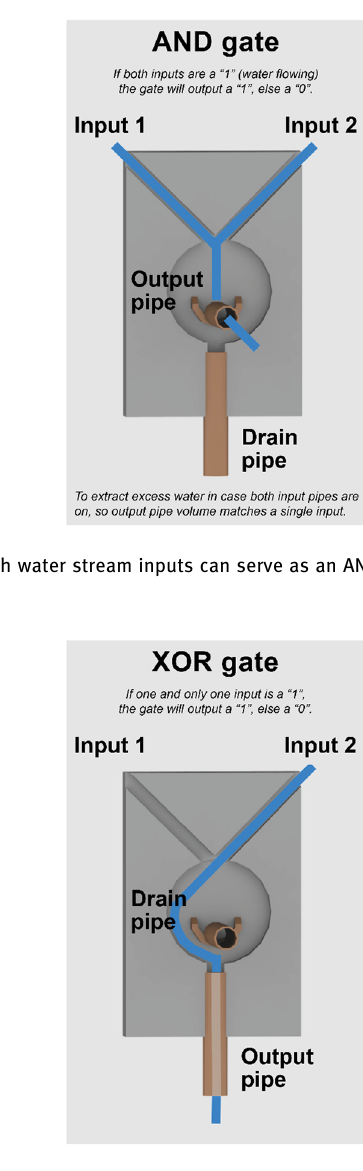
Figure 2: Example mechanism by which water stream inputs can serve as a XOR logic gate.